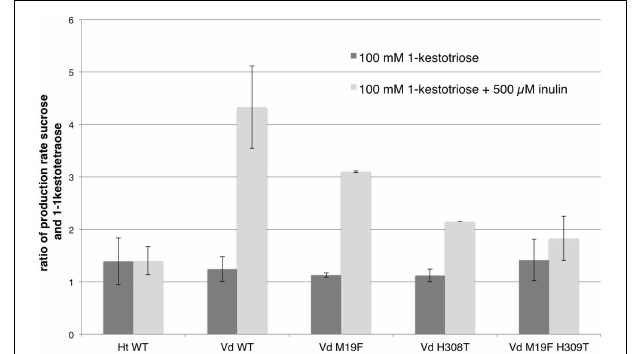
FIGURE 3 | Comparison of the mean ( n = 3 , except for single mutants n = 2 ; with standard deviation indicated) of the ratios of the production rates for sucrose and 1,1-kestotetraose for both WT 1-FFTs, single mutant and double mutant Vd 1-FFT. The dark gray bars show the ratio of production rates of sucrose and 1-kestotetraose when using 100mM of 1-kestotriose as sole substrate. The light gray bars show the ratio when supplementing the reaction with 500 µ M